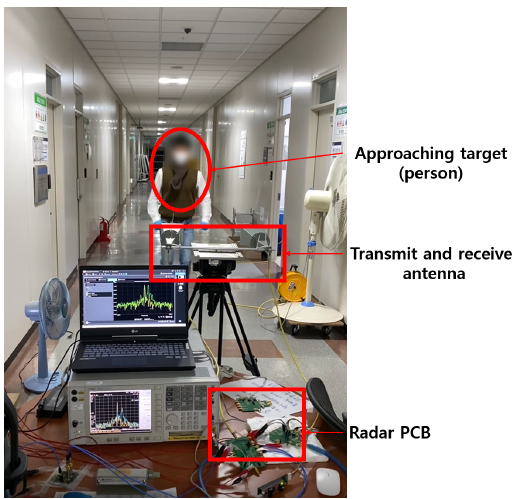
Figure 43. Measurement environment for radar test.